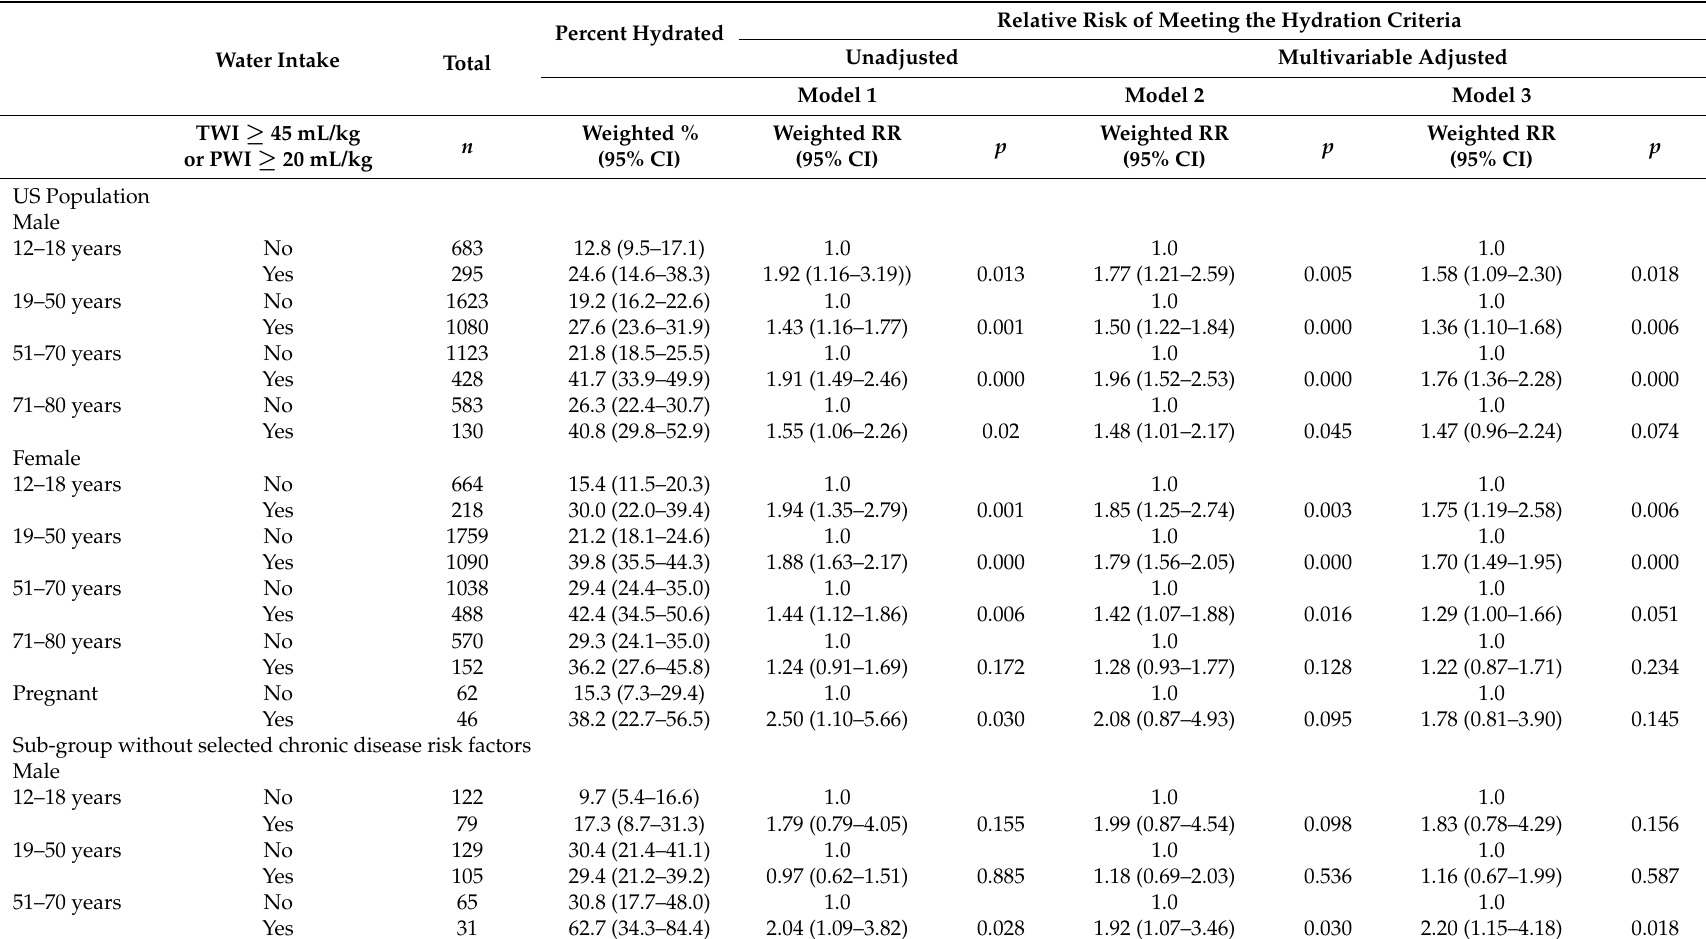
Table 4. Relative risk of meeting the hydration criteria associated with TWI ≥ 45 mL/kg or PWI ≥ 20 mL/kg for the US population aged 12–80 years in